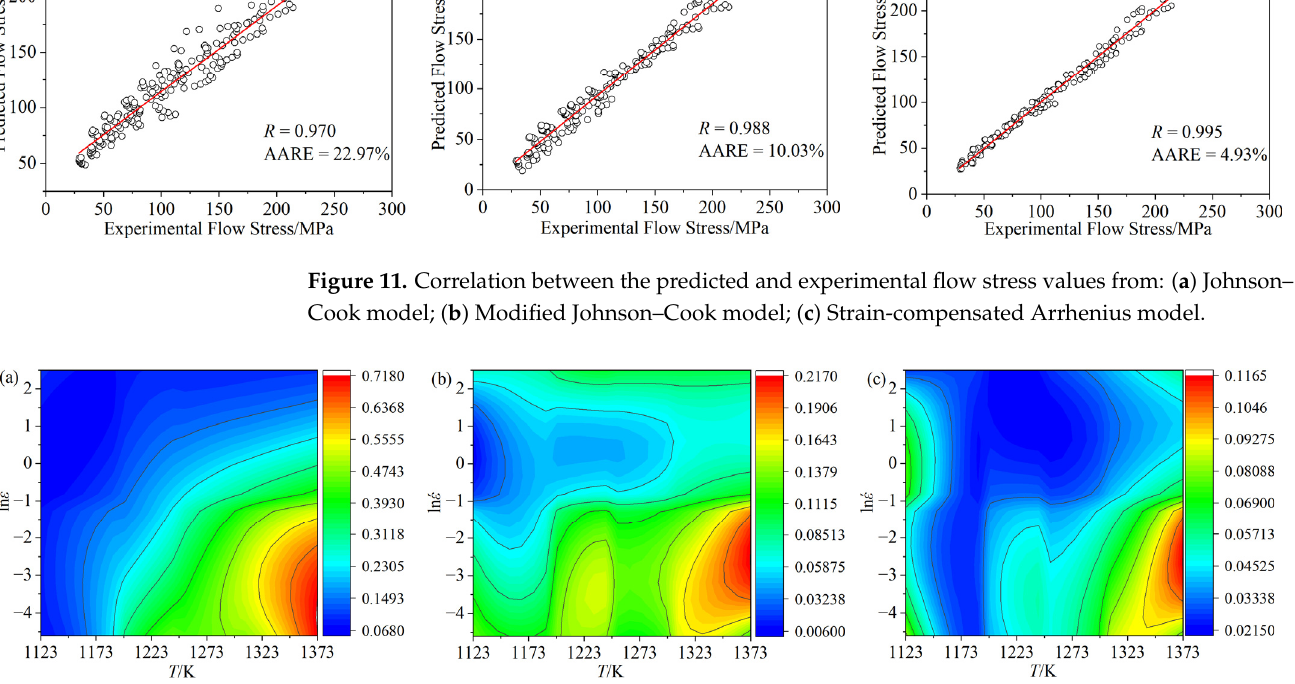
Figure 12. Comparison of the AARE for: ( a ) Johnson–Cook model; ( b ) Modified Johnson–Cook model; ( c ) Strain-compensated Arrhenius model.